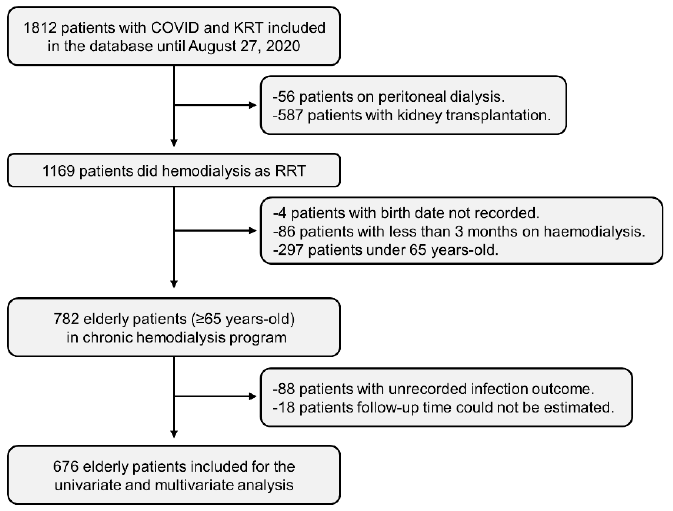
Figure 1. Study flow diagram. KRT: Kidney Replacement Therapy.